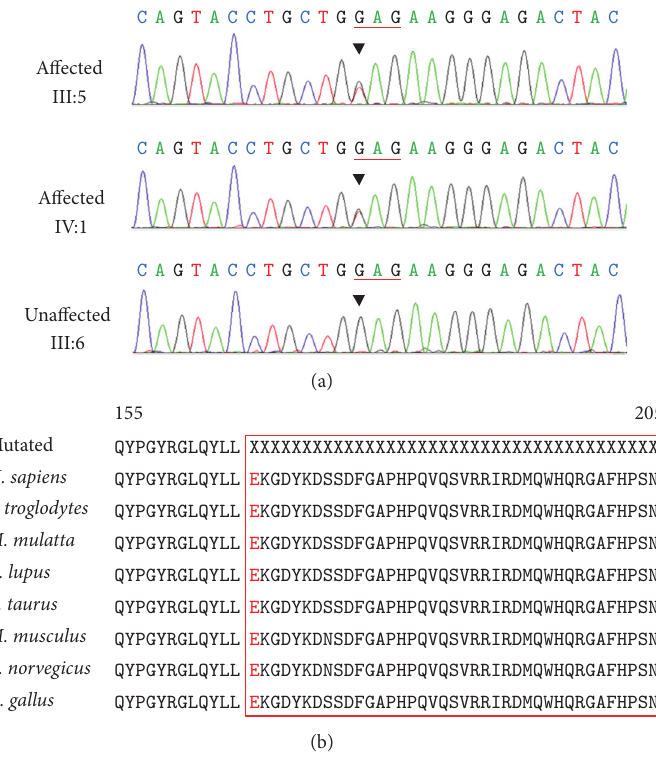
Figure 3: Representative chromatogram of CRYBB2 sequence. (a) Sanger sequencing analysis of the affected and unaffected individuals in the ADCC Chinese family, showing a heterozygous mutation (c.499G > T) in exon 6 of CRYBB2 (black triangles). Moreover, this transition resultedin astopgain mutation. (b)Multiple-sequence alignment in CRYBB2 fromdifferentspecies reveals thatcodon 167, wherethemutation (p.E167X) occurred, is highly conserved (highlighted in red box).